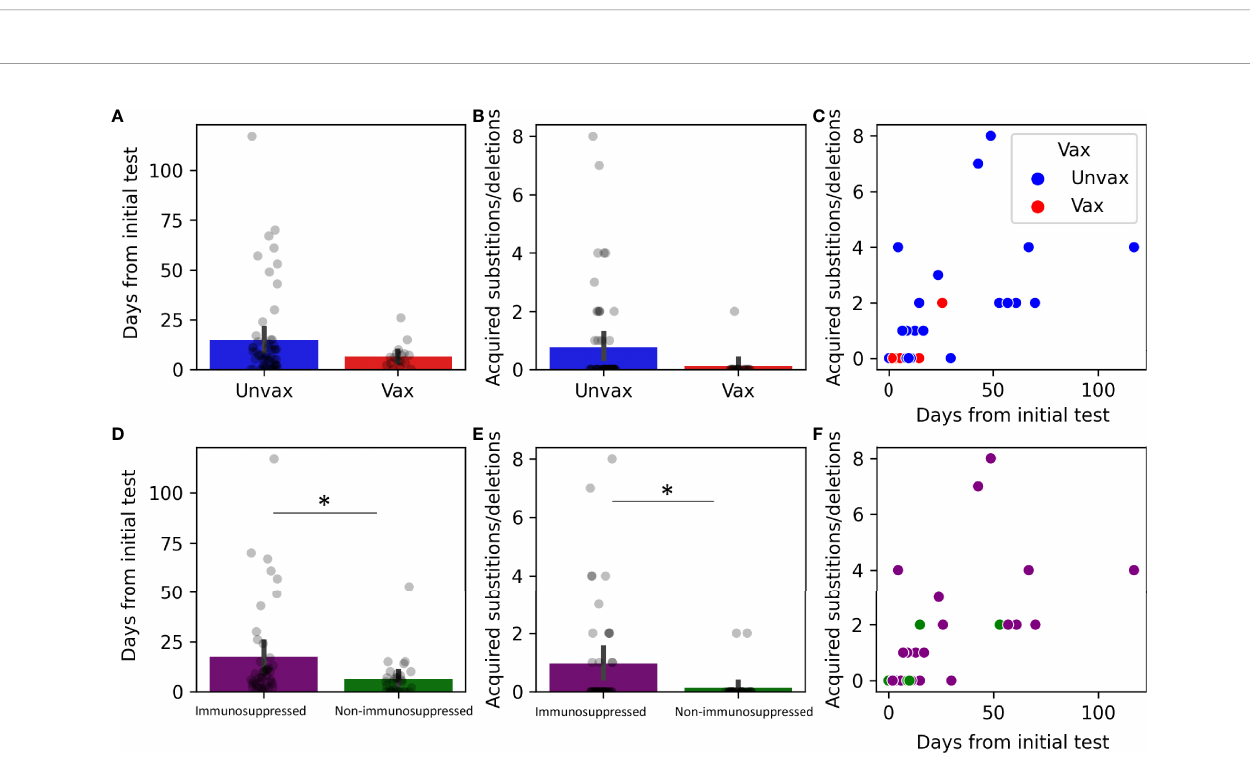
FIGURE 5 | Genomic changes in prolonged viral shedding. (A) Frequency of amino acid changes (substitutions and deletions) per protein in a cohort of 75 patients with two or more complete genomes from samples collected 0 - 117 days after the fi rst positive. (B) Amino acid changes as a factor of time between collected positive samples.